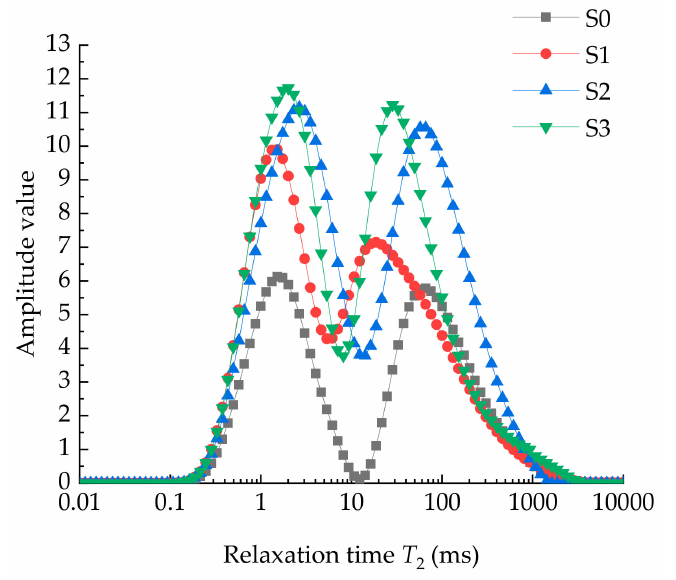
Figure 2. Distribution characteristics of T 2 spectra of granite corroded by mud acid solutions with three different concentration (S1–S3) (S0 is the original granite sample without mud acid corrosion for